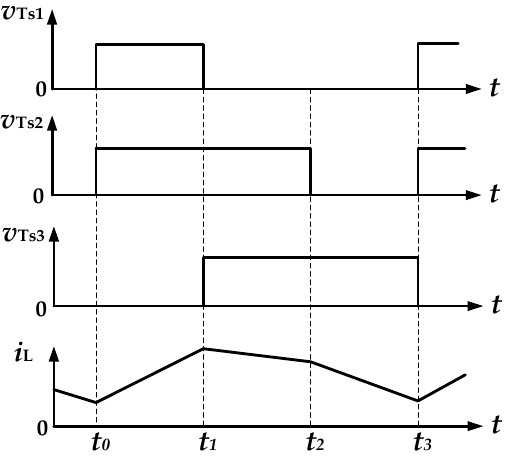
Figure 6. Waveforms in dual input single output (DISO) mode.